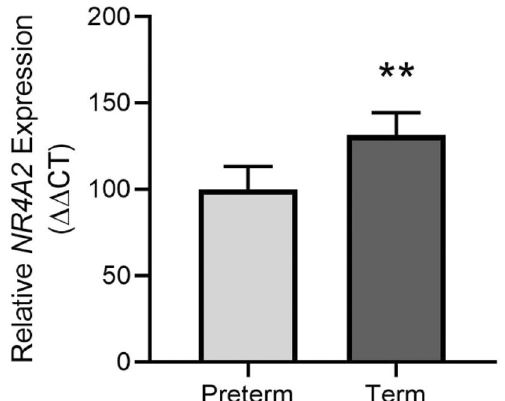
Figure 2. NR4A2 expression in preterm and term placental tissue assessed by qPCR. Term placental tissue had significantly higher NR4A2 mRNA expression compared to preterm tissue. Data presented as relative